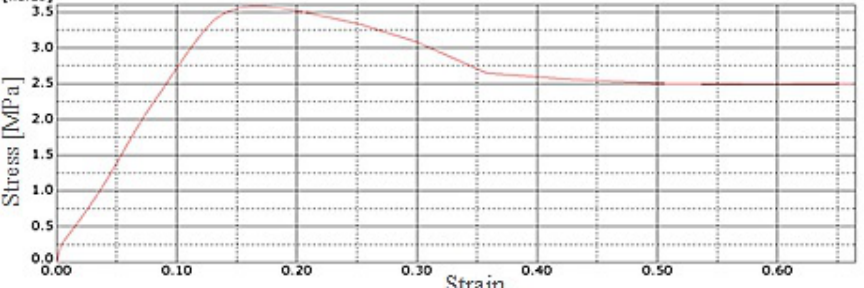
Figure 16. Variations of stress–strain for case 10 model.